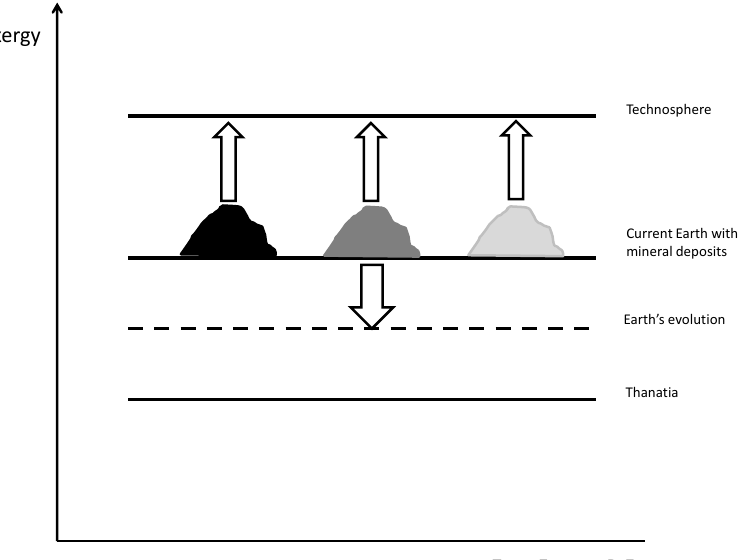
Figure 1. Graphical representation of the exergy associated with the minerals in the technosphere, the mineral deposits and Thanatia with respect to the reference